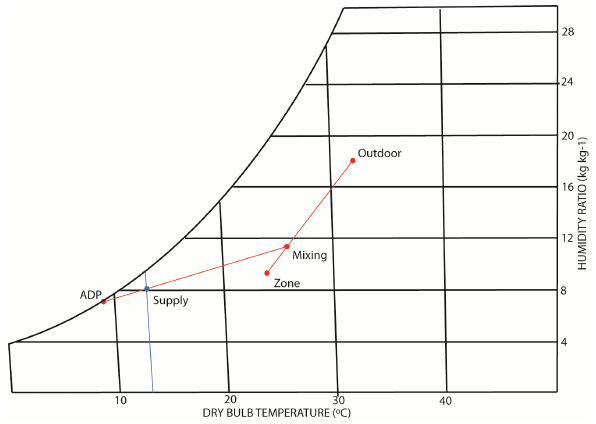
Fig. 2. Psychrometric chart of humid air. The significant points of the HVAC system model for a cooling situation are represented. Zone conditions refer to the temperature and humidity of the indoor air. Recirculated air from the zone is mixed with outdoor air before entering the cooling coil (mixing conditions). The air leaves the cooling coil at supply conditions. The apparatus dewpoint (ADP) is an input of the model and represents the temperature of the air leaving the cooling coil if this would be saturated.